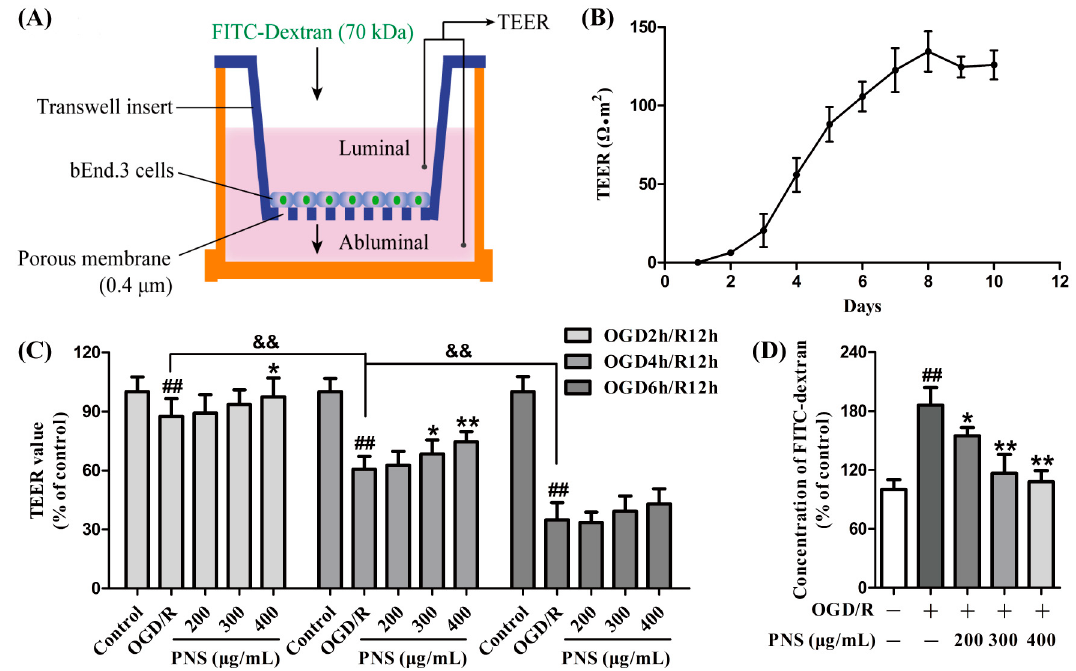
Figure 2. The protective effects of PNS against OGD/R-induced disruption of in vitro BBB integrity. ( A ) Illustration of the in vitro BBB model that bEnd.3 cells were seeded on a membrane of transwell insert, and the TEER and paracellular diffusion of FITC-dextran (70 kDa) were measured. ( B ) The barrier function of the bEnd.3 cell monolayer was evaluated by TEER value for 10 days. ( C ) The TEER assay to evaluate the protective effect of PNS against OGD/R-induced disruption of barrier function in different injury time. ( D ) The paracellular diffusion assay to further confirm the protective role of PNS on OGD4h/R12h-induced barrier disruption. Data are expressed as mean ± SD (N = 3). && p < 0.01, ## p < 0.01 vs. Control group, * p < 0.05 and ** p < 0.01 vs. OGD/R group.